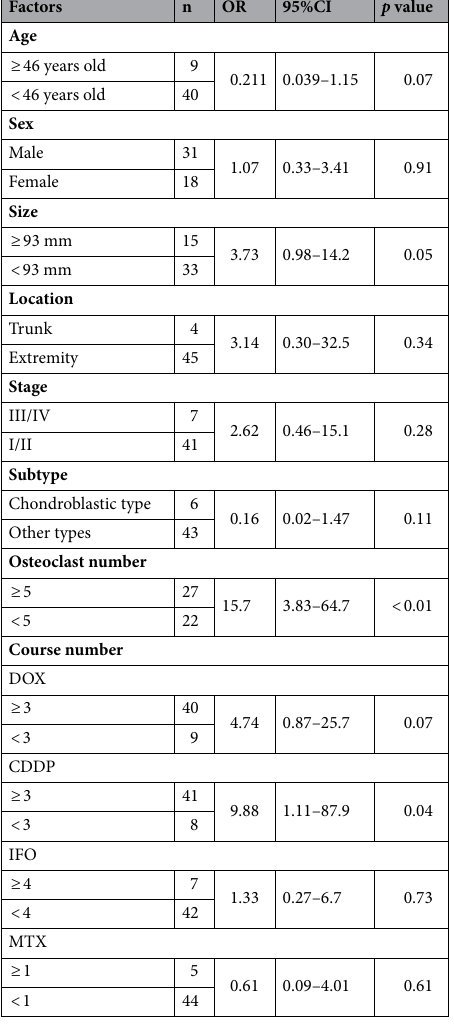
Table 2. The univariate analysis of factors for predicting the good response of chemotherapy. DOX: doxorubicin, CDDP: cisplatin, IFO: ifosfamide, MTX: methotrexate, OR:odds ratio, CI: confidence